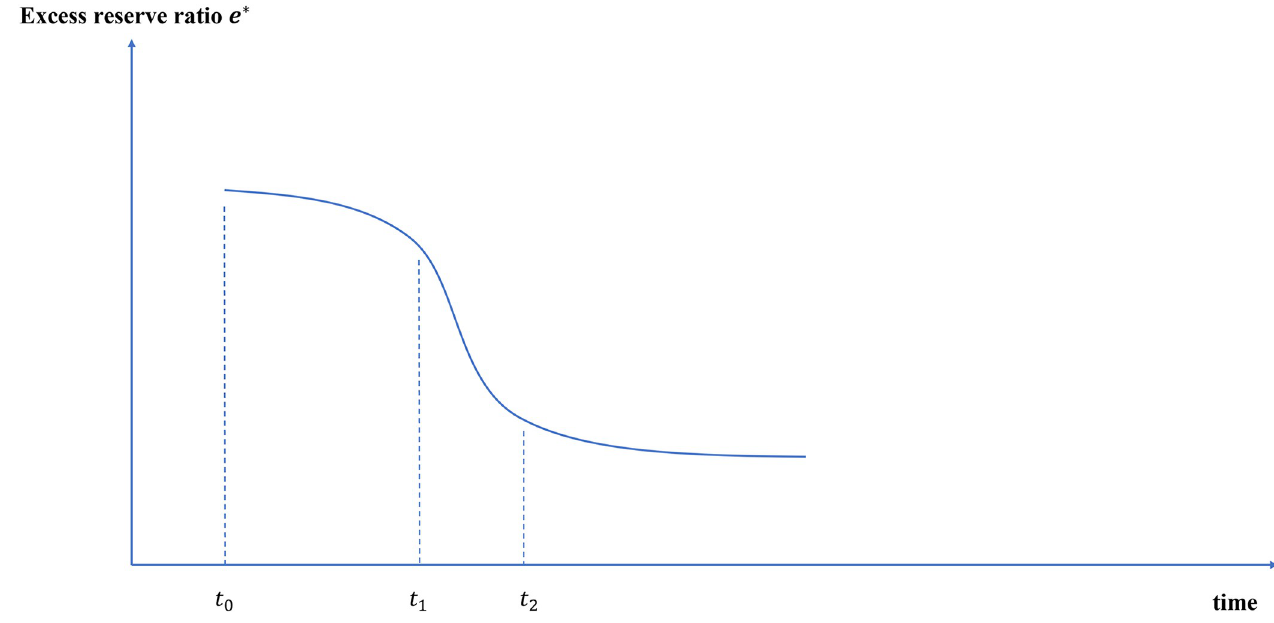
Fig 12. Path changes of excess reserve ratio after e-CNY issuance.